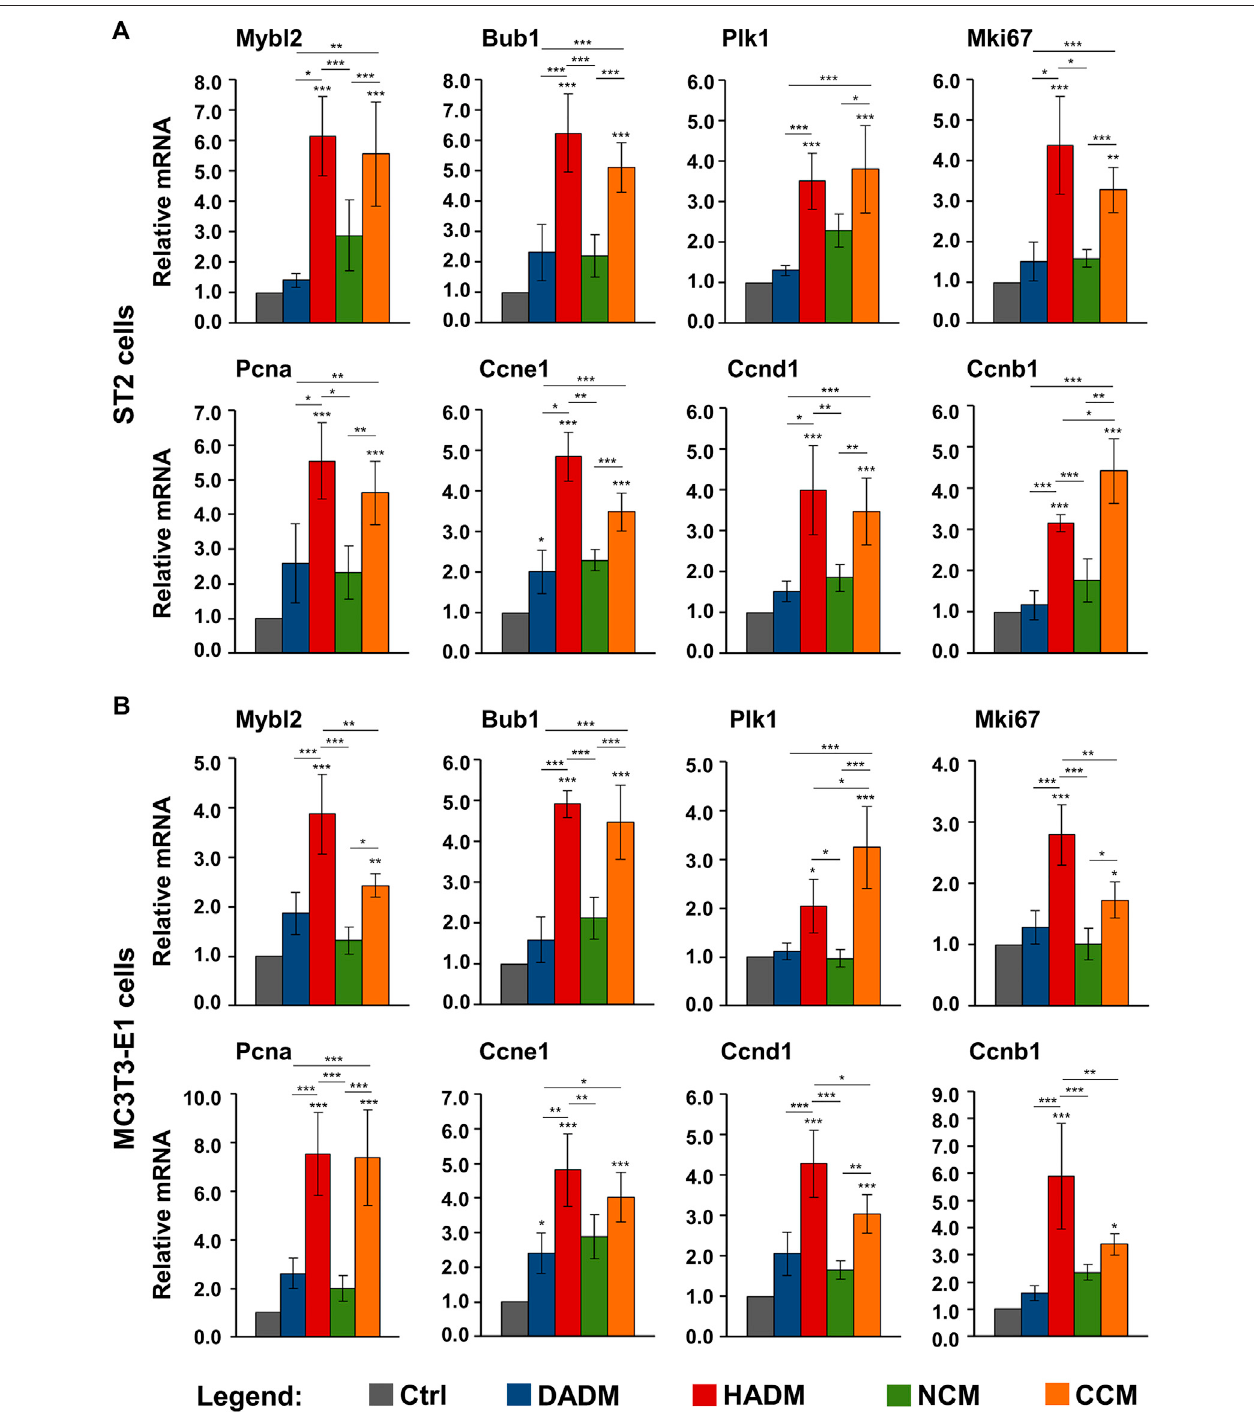
FIGURE3| IncreasedexpressionofproliferatemarkergenesinosteoprogenitorcellsgrownonHADMandCCMcollagen-basedmatrices.ST2 (A) andMC3T3-E1 (B) cells were grown on DADM, HADM, NCM, or CCM collagen-based matrices for 3 days before total cellular RNA was extracted and analyzed for the expression of Mybl2, Bub1, Plk1, Mki67, Pcna, Ccne1, Ccnd1, and Ccnb1 proliferative marker genes by qRT-PCR. Controls (Ctrl) represent cells of each cell type grown in the absence of a collagen matrix. Values normalized to Gapdh are expressed relative to the values of control cells. Data represent means ± SD from four independent experiments performed with each of the two cell lines. Signi fi cant differences to the respective controls unless otherwise indicated, *** p < 0.001, ** p < 0.01, * p < 0.05.